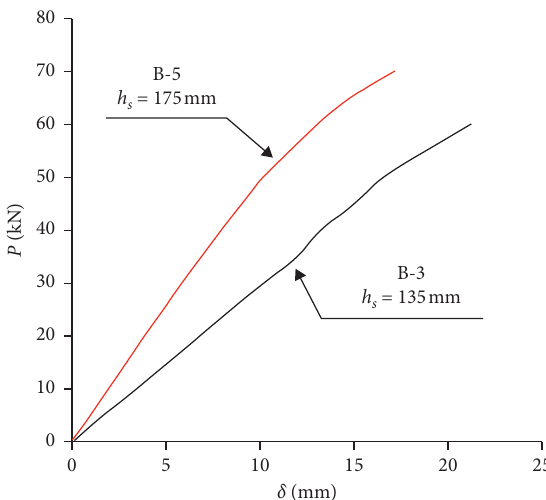
Figure 10: Effect of sectional dimension of steel channel on load-deflection curve.